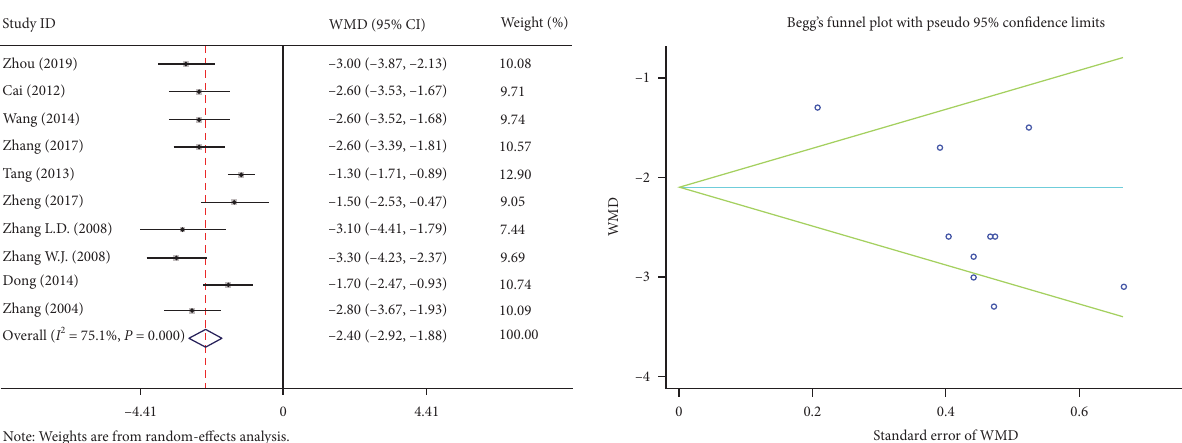
Note: Weights are from random-effects analysis. F IGURE 4: Forest plot and funnel plot of the postoperative hospital stay between the primary suture group and the T-tube drainage